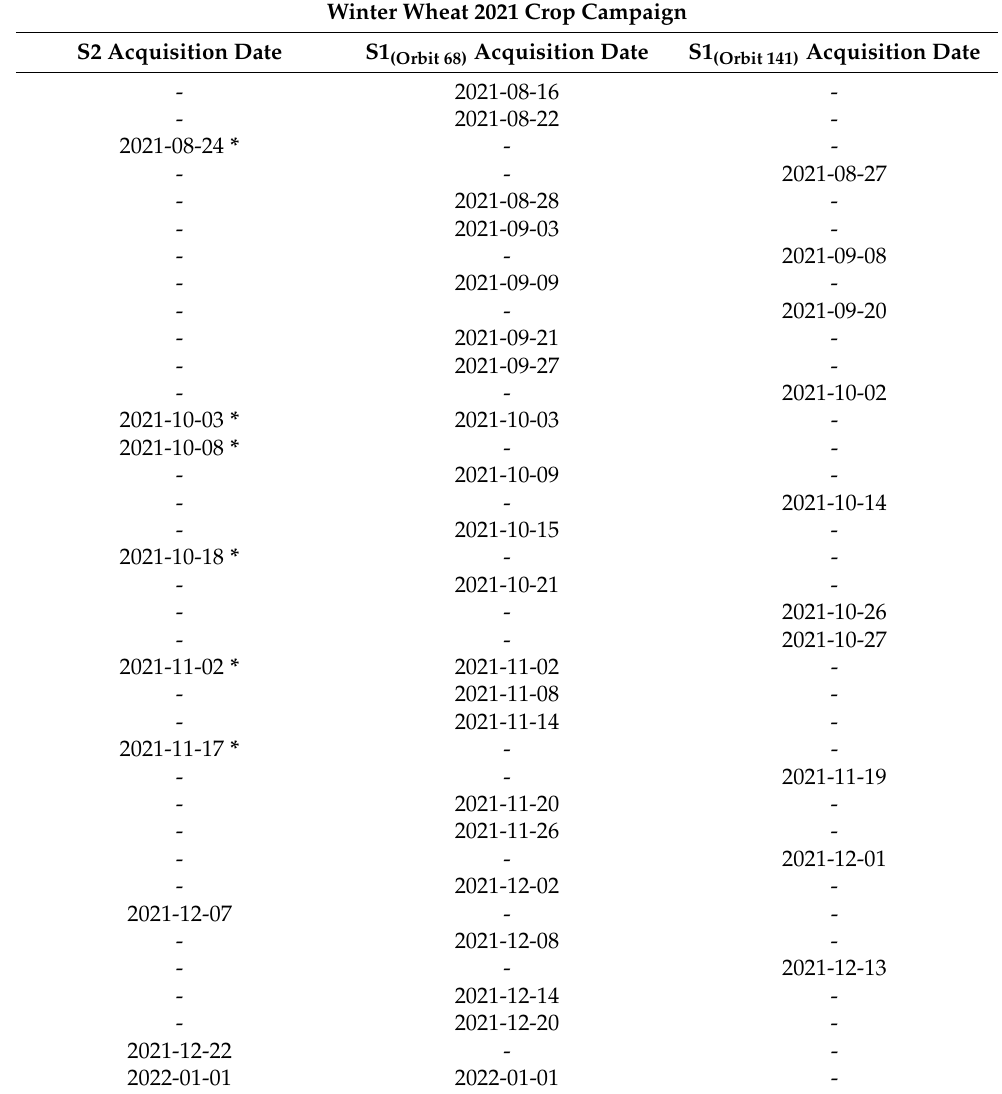
Table A2. Sentinel–2 and Sentinel–1 acquisition dates corresponding to the winter wheat 2021 crop campaign at the BVCR. The (–) symbol means no acquisition. The ( * ) indicates the S2 removed images from the S1 & S2 dataset for model